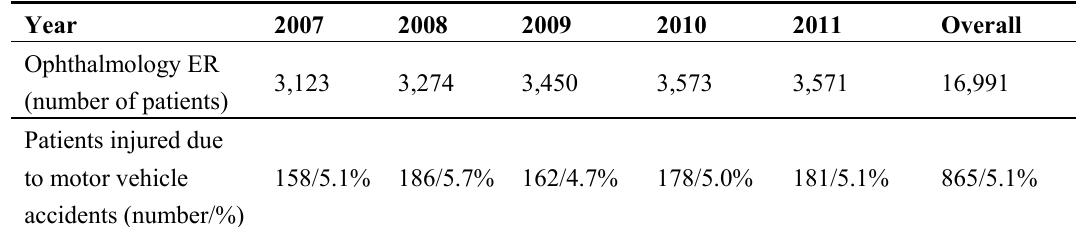
Table 1. Ophthalmology Emergency Room statistics during 2007–2011.